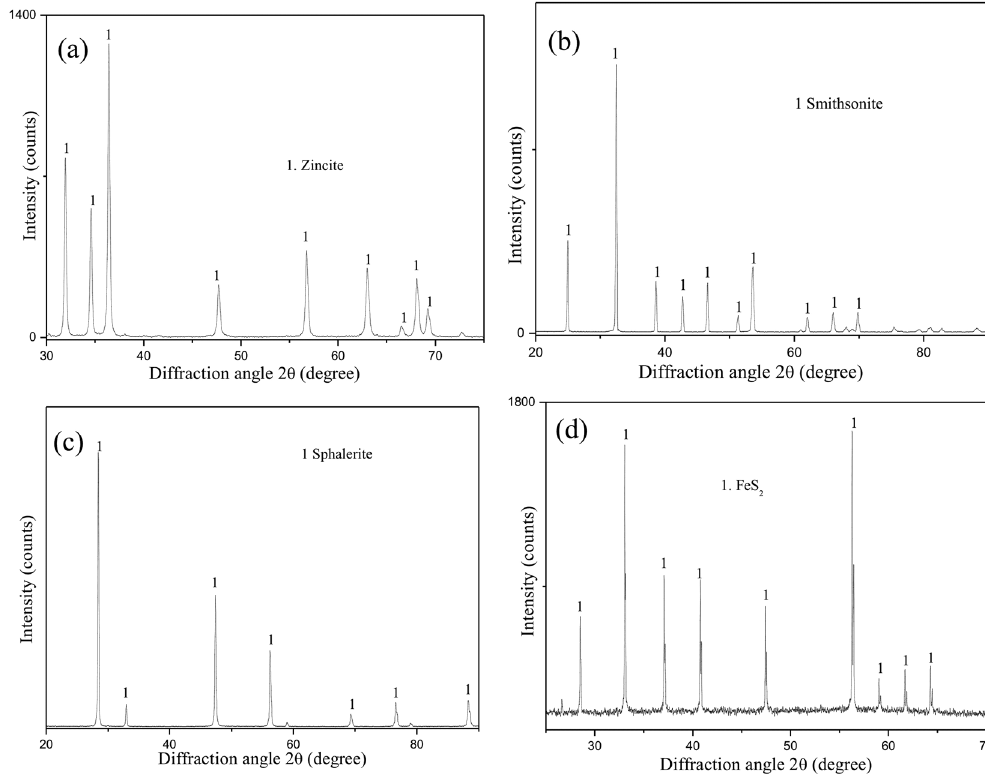
Figure 1. XRD patterns of the synthesized and natural samples ( a ) synthesized ZnO; ( b ) natural smithsonite; ( c ) natural sphalerite; ( d ) natural